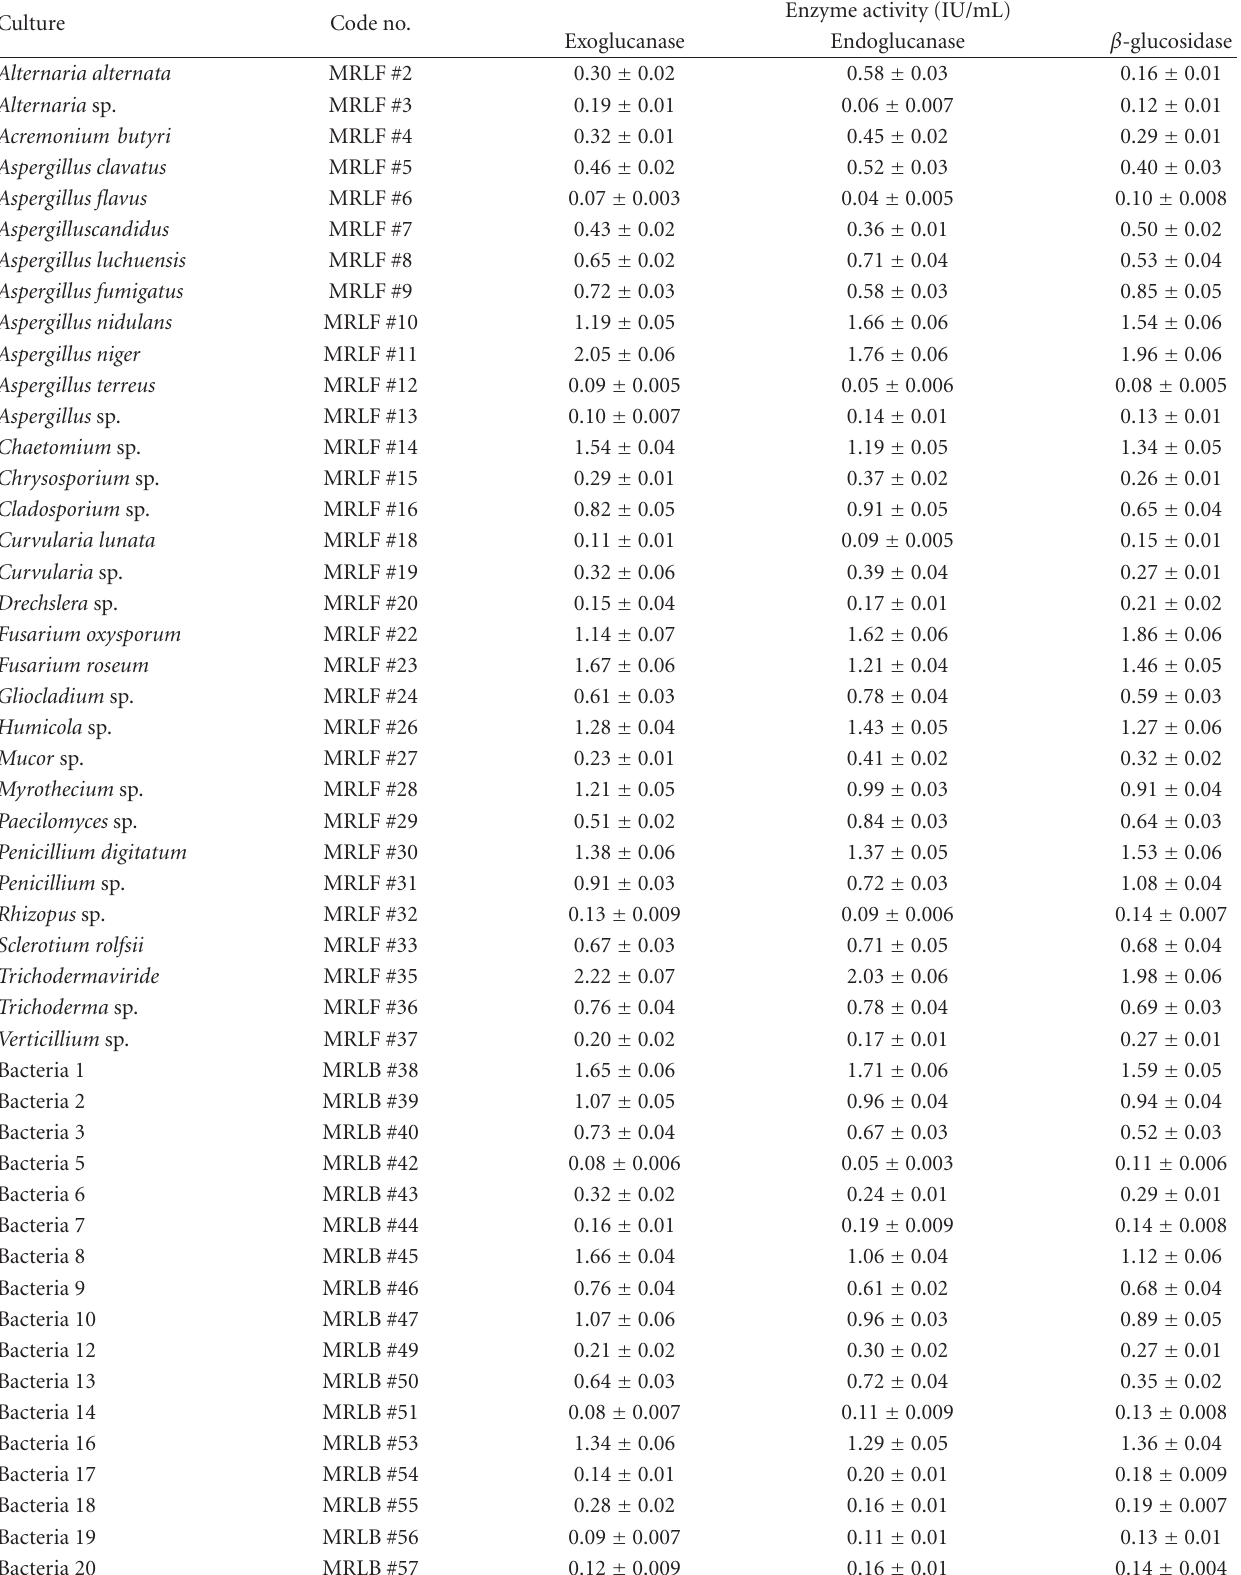
Table 2: Secondary screening of cellulose-producing